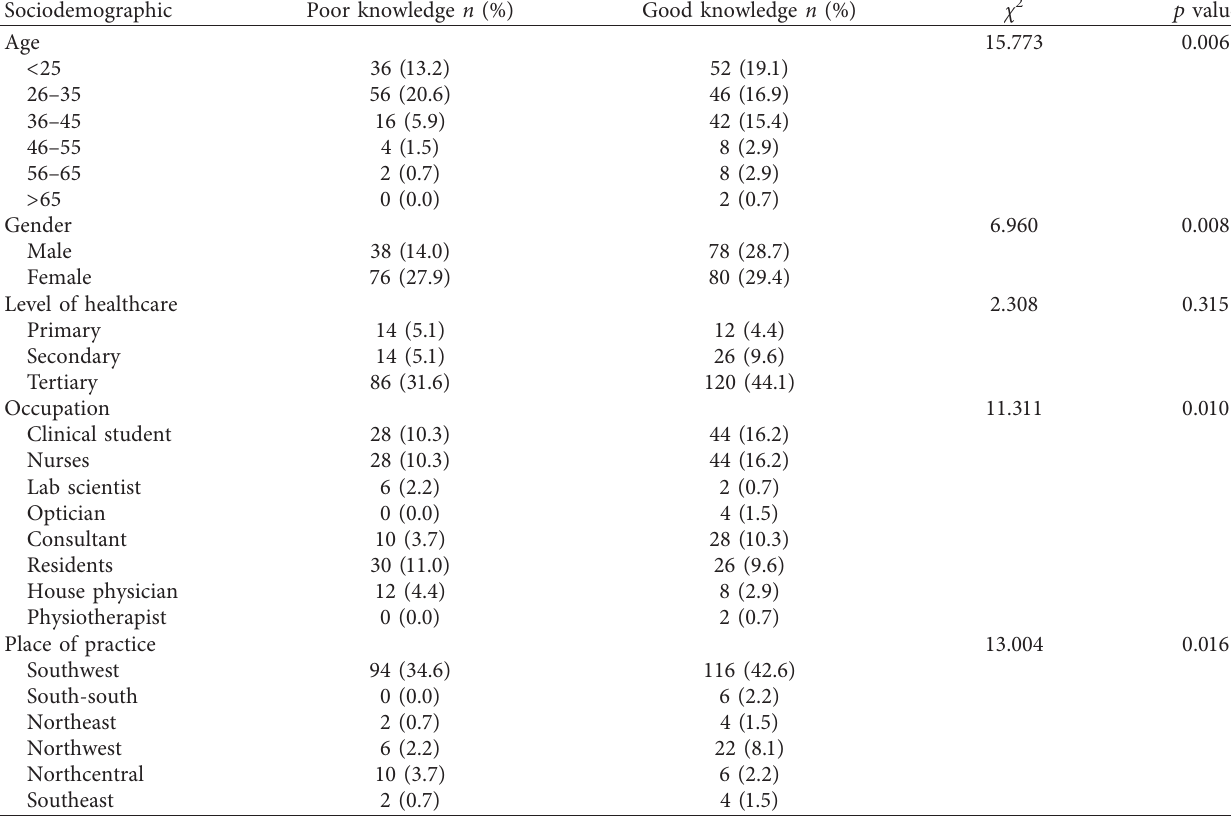
Table 5: Association between sociodemographic characteristics and knowledge of respondents about PPE.